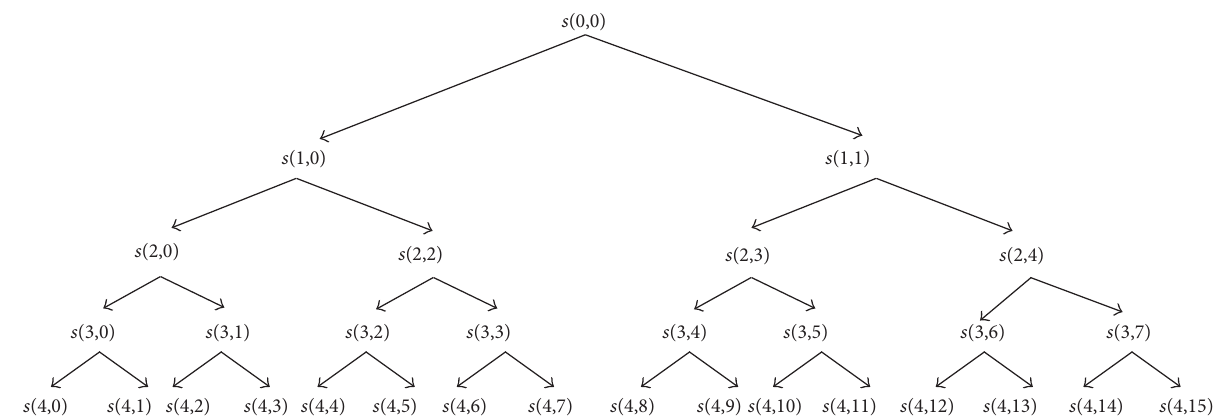
Figure 2: Wavelet packet decomposition